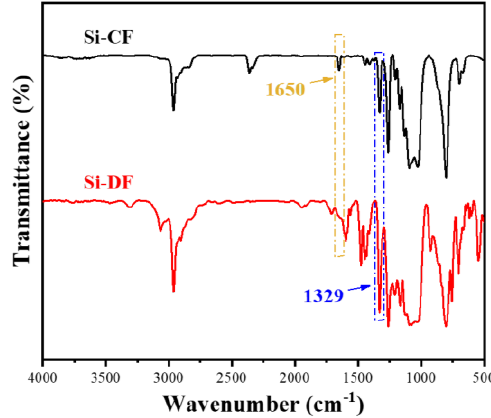
Figure 2. FTIR spectra of Si-CF and Si-DF.